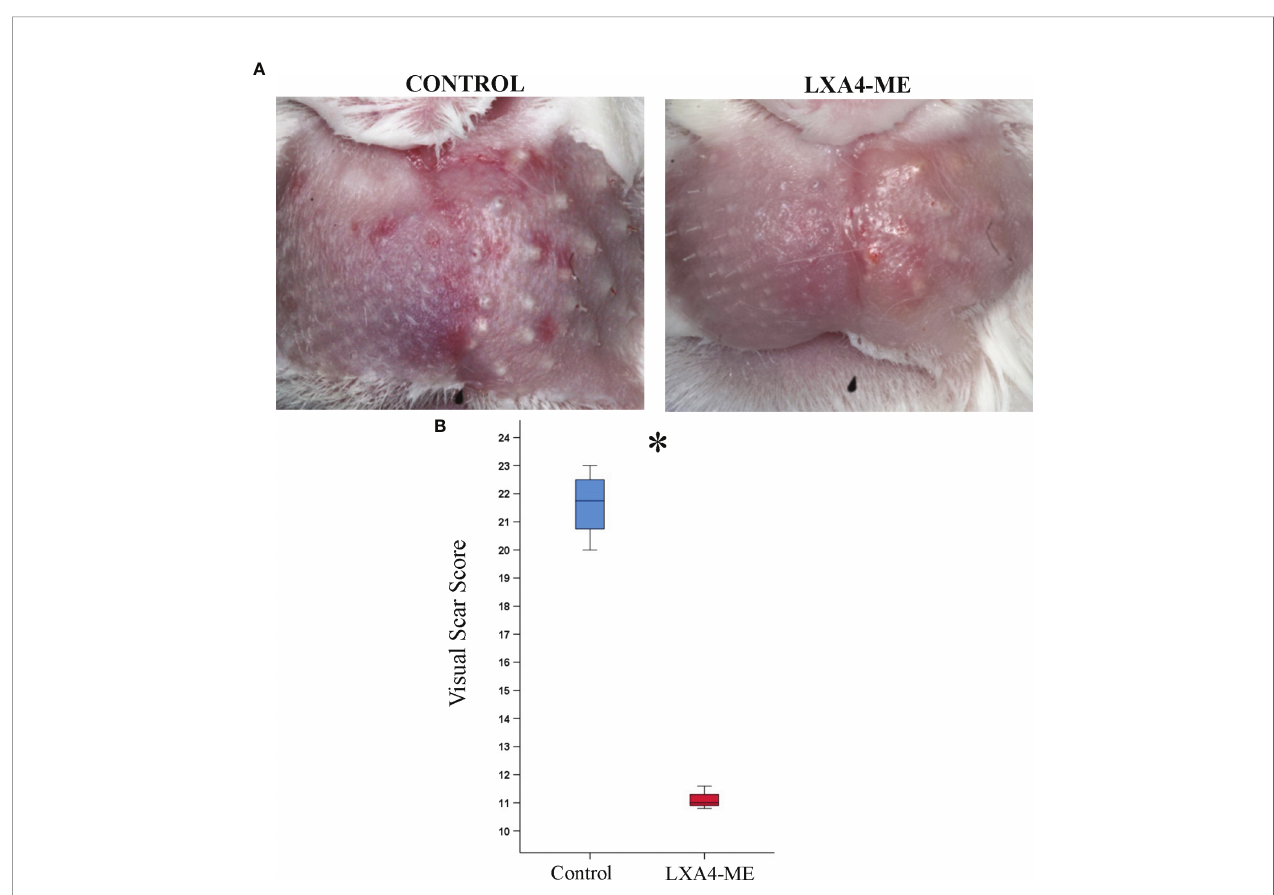
FIGURE 2 | Visual Scar Assessment. (A) Clinical photographs 42 days after cleft lip repair surgery in rabbits treated with phosphate-buffered saline (PBS) (control) or with methyl-ester of lipoxin A 4 (LXA 4 -ME) (treatment). (B) Animals treated with LXA 4 -ME demonstrated reduced visual scarring scores assessed with the Modi fi ed Manchester Scar Scale (median=11.00; 25 th ; 75 th percentile=10.95, 11.15) compared to animals that received only PBS (control) (median=21.75; 25 th ; 75 th percentile=21.12, 22.25) (statistically signi fi cant at *P < 0.05, Mann-Whitney U test; n=4